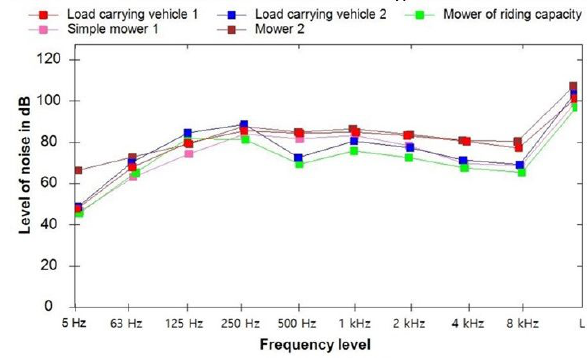
Figure 3: Vibration noise content due to various types of